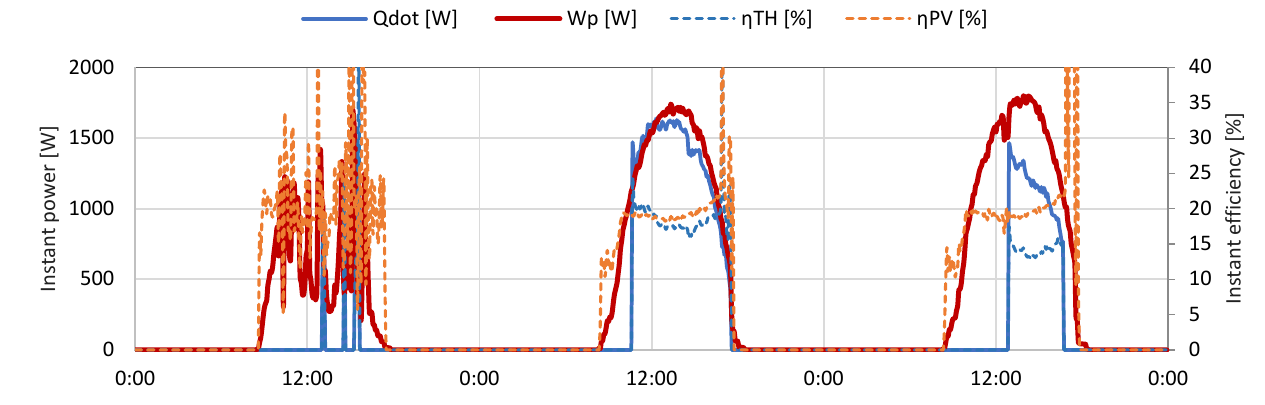
Figure 9. Detail of three days in winter: thermal and electrical power and efficiencies for a cloudy, clear, and windy day.